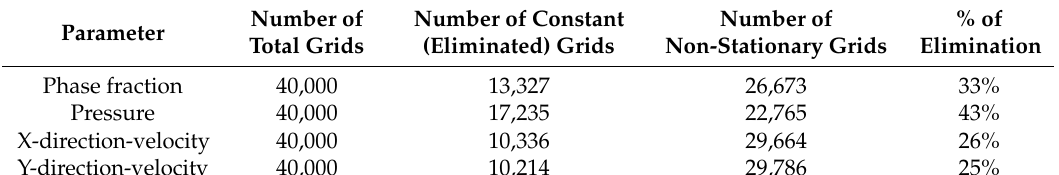
Table 4. Percentage of eliminated data for each parameter.